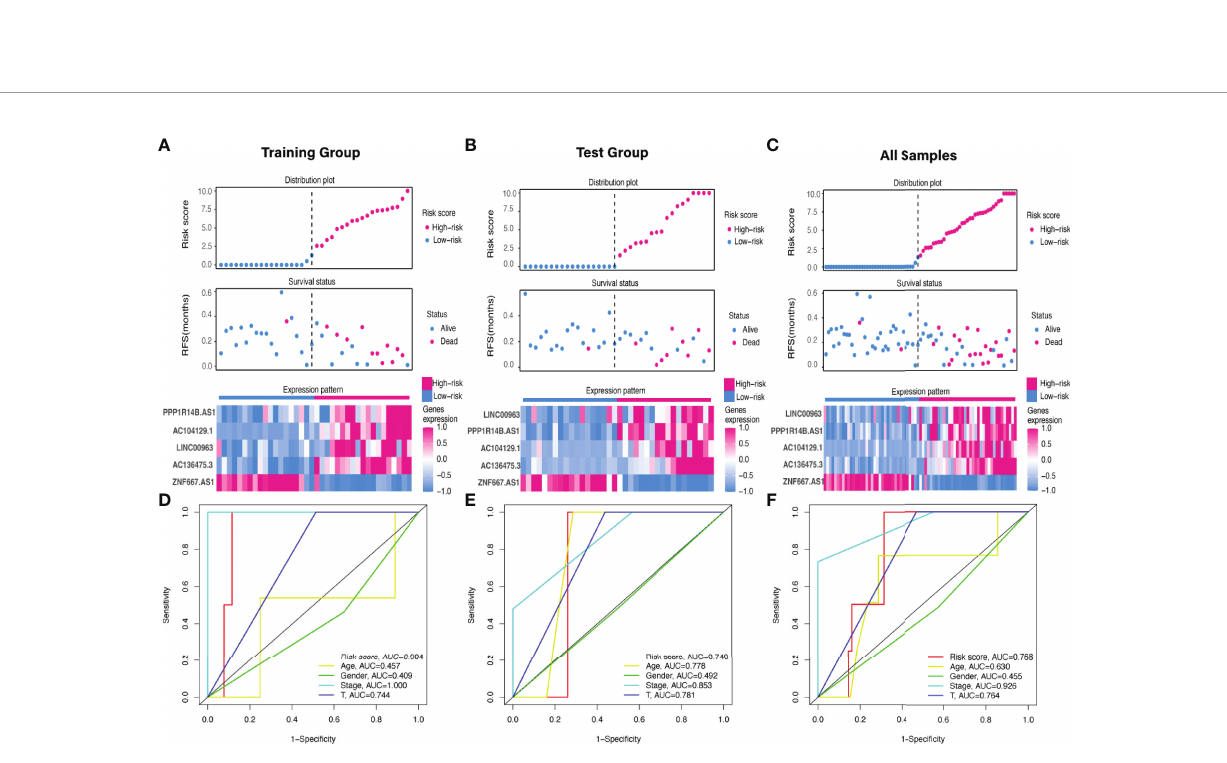
FIGURE 5 | Evaluation of the FRLs signature predictive ability. (A – C) The distribution plots, survival status, and expression trends of the different risk score in the (A) training, (B) test, and (C) all cohorts. (D-F) ROC curves of risk score, age, gender, stage, and T classi fi cation in the (D) training, (E) testing, and (F) all